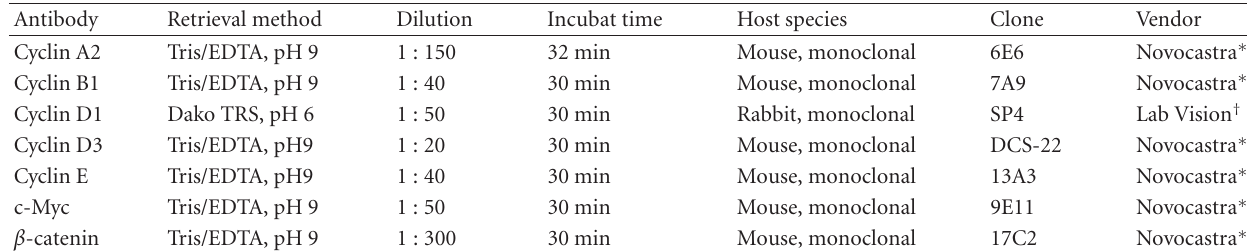
Table 1: Primary antibodies used for